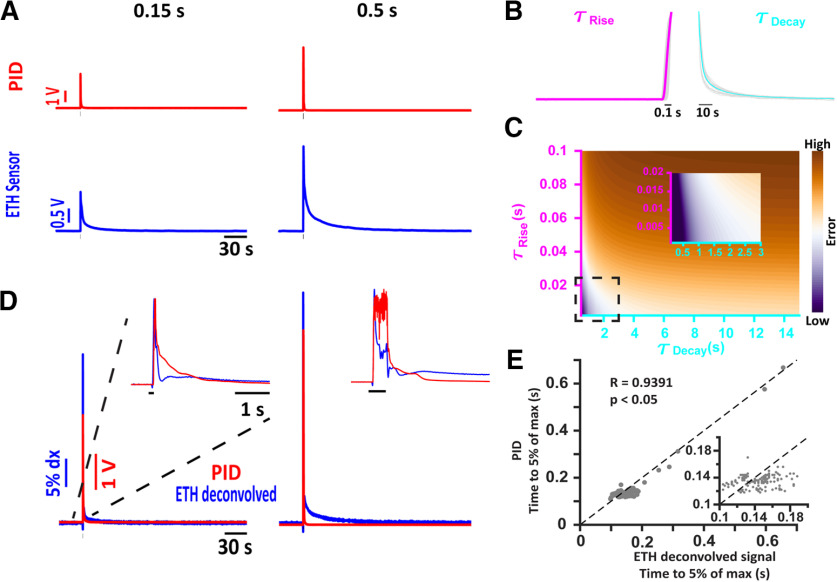
 Ethanol-sensor response can be deconvolved using a difference of two exponential kernel. A, Representative traces of the PID (red) and the ethanol-sensor (blue) response to brief ethanol presentations. The duration of the ethanol pulse is indicated at the top of each column. B, Ethanol-sensor responses from individual presentations (gray) were averaged to estimate the rise time (τRise) to be around 60 ms (magenta) and the decay time (τDecay) to be around 3.5 s (cyan). C, Optimization of the deconvolution kernel by minimizing the mean error between the deconvolved ethanol responses and the PID responses (see Materials and Methods) using a family of kernels with varying τRise and τDecay values. D, The deconvolved ethanol signal (blue) from the raw recordings of the ethanol sensor shown in A compared with the PID recordings. The inset shows the zoomed-in view of the normalized deconvolved ethanol response and the PID response to compare the waveforms of the PID response and the deconvolved ethanol signal. The black bar in the inset shows the duration of ethanol presentation. E, A linear relation exists between the threshold time (time from the valve opening to 5% of the max) between the deconvolved ethanol signals and the PID responses. Inset shows the zoomed-in view of the cluster of points in the ranges shown.